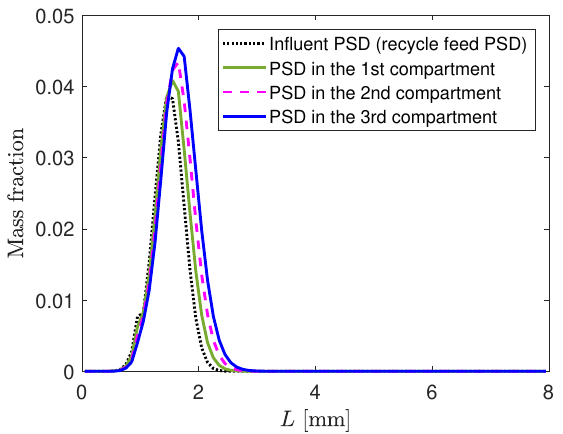
Figure 4: PSD in the 1st, 2nd and 3rd compartments of the 3-compartment granulator for L crush = 1 . 5